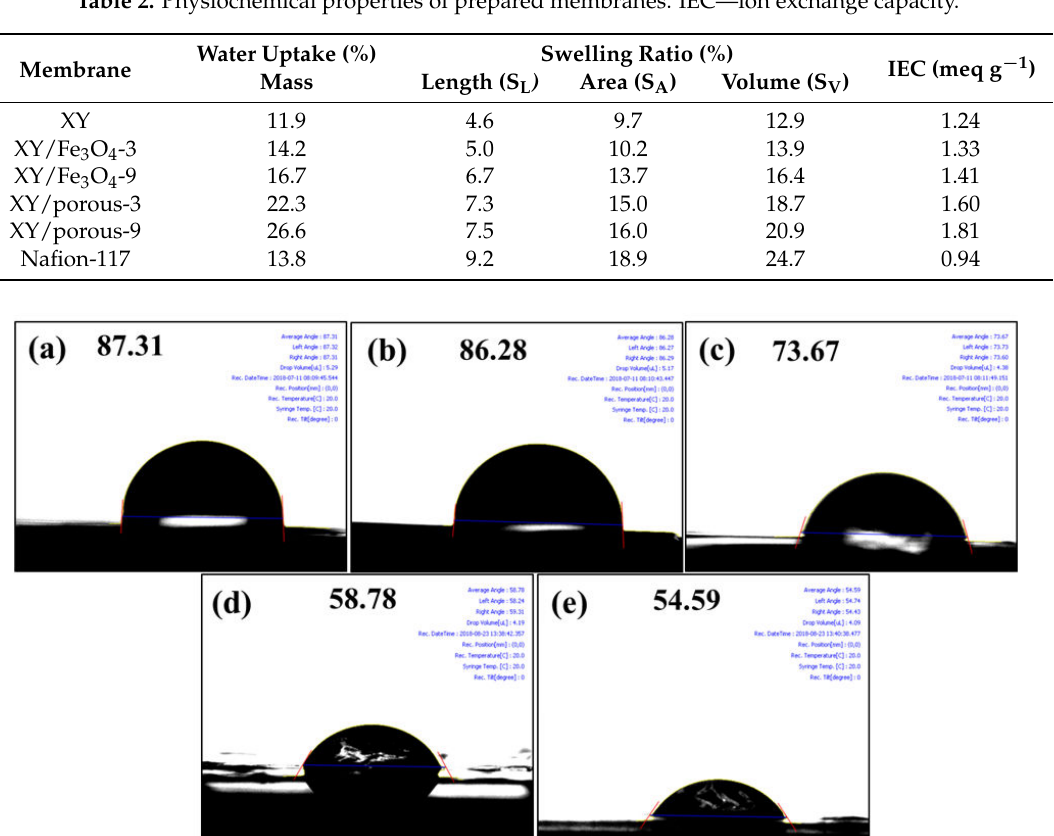
Figure 10. Water contact angle images of ( a ) bare XY, ( b ) XY/Fe 3 O 4 -3, ( c ) XY/Fe 3 O 4 -9, ( d ) XY(porous)-3, and ( e ) XY(porous)-9